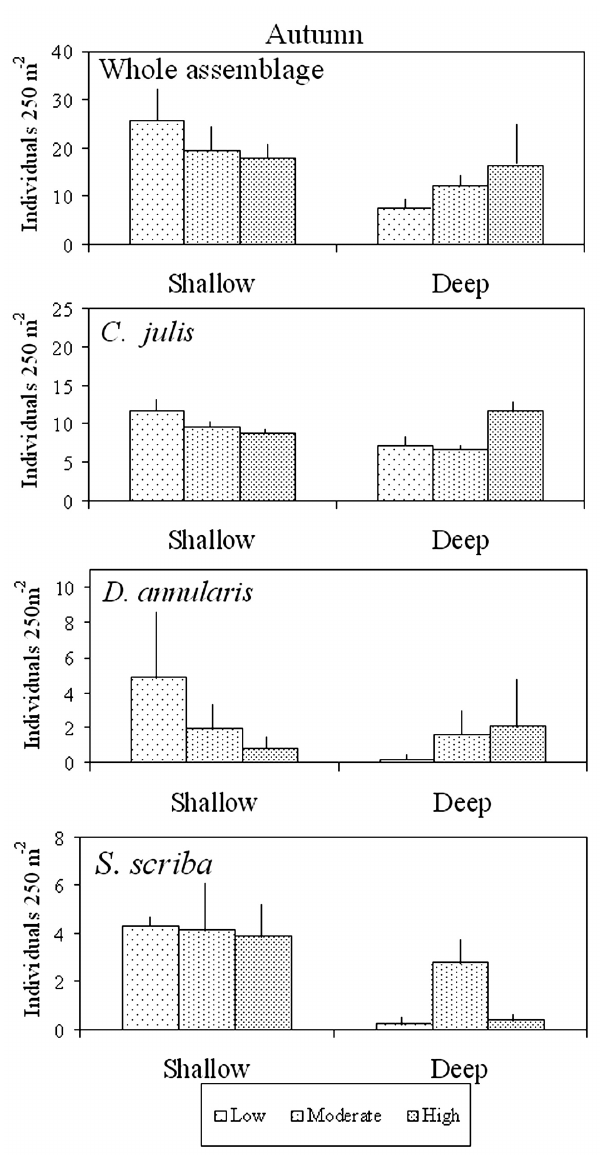
F IG . 8. – Density of vulnerable fish in autumn. Vertical bars show standard